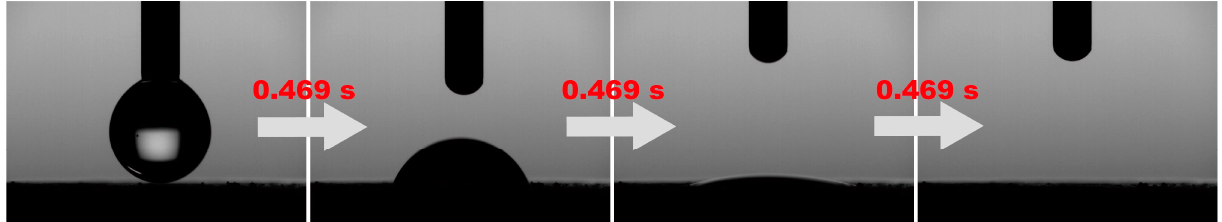
Figure 3. Water wettability of PHI-1090